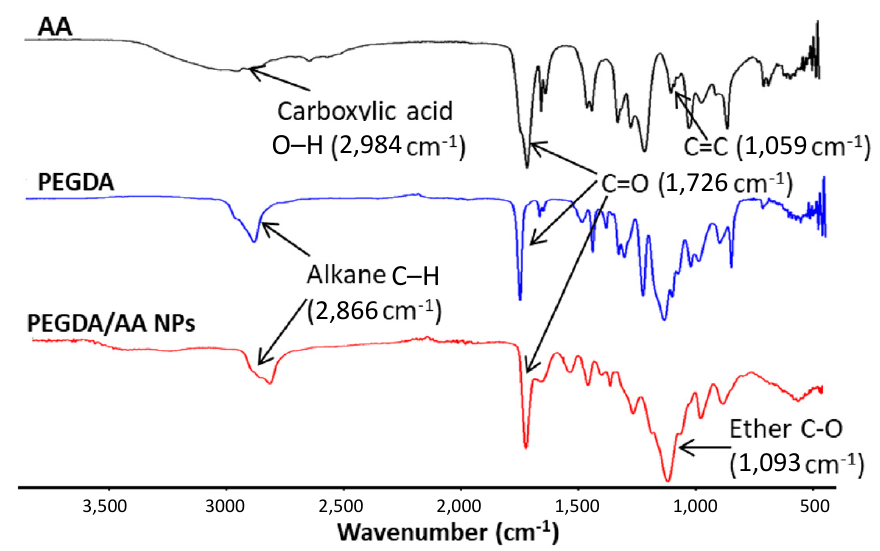
Figure 3. FTIR spectra of AA, PEGDA and PEGDA/AA NPs.